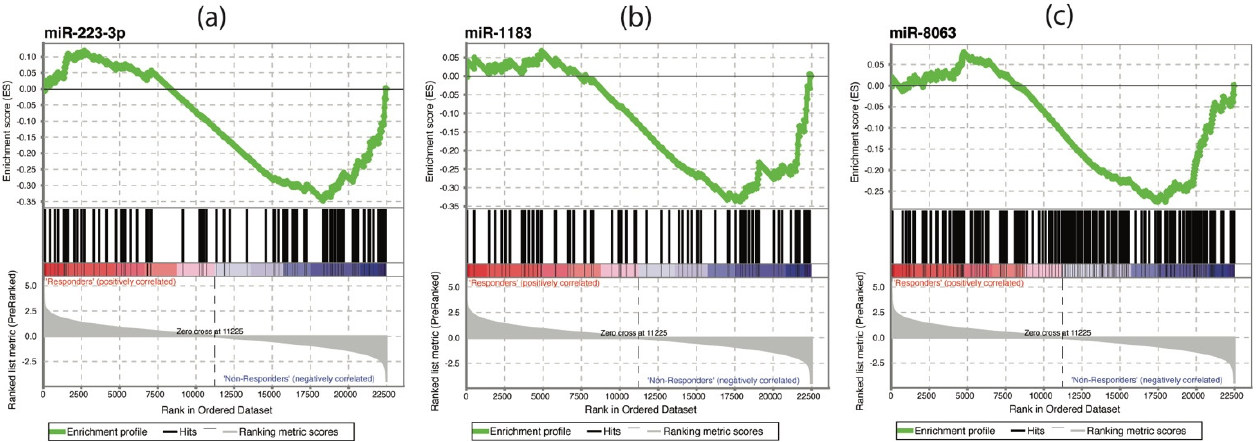
Figure 4. Significant enrichment plots in the GSEA performed with gene sets including genes regulated by the significantly differentially expressed miRNAs. ( a ) The gene set defined by genes regulated by miR-223-3p was significantly down- regulated in responders ( p = 0.014). ( b ) The gene set defined by genes regulated by miR-1183 was significantly down- regulated in responders ( p = 0.030). ( c ) The gene set defined by genes regulated by miR-8063 was significantly down- regulated in responders ( p = 0.024).